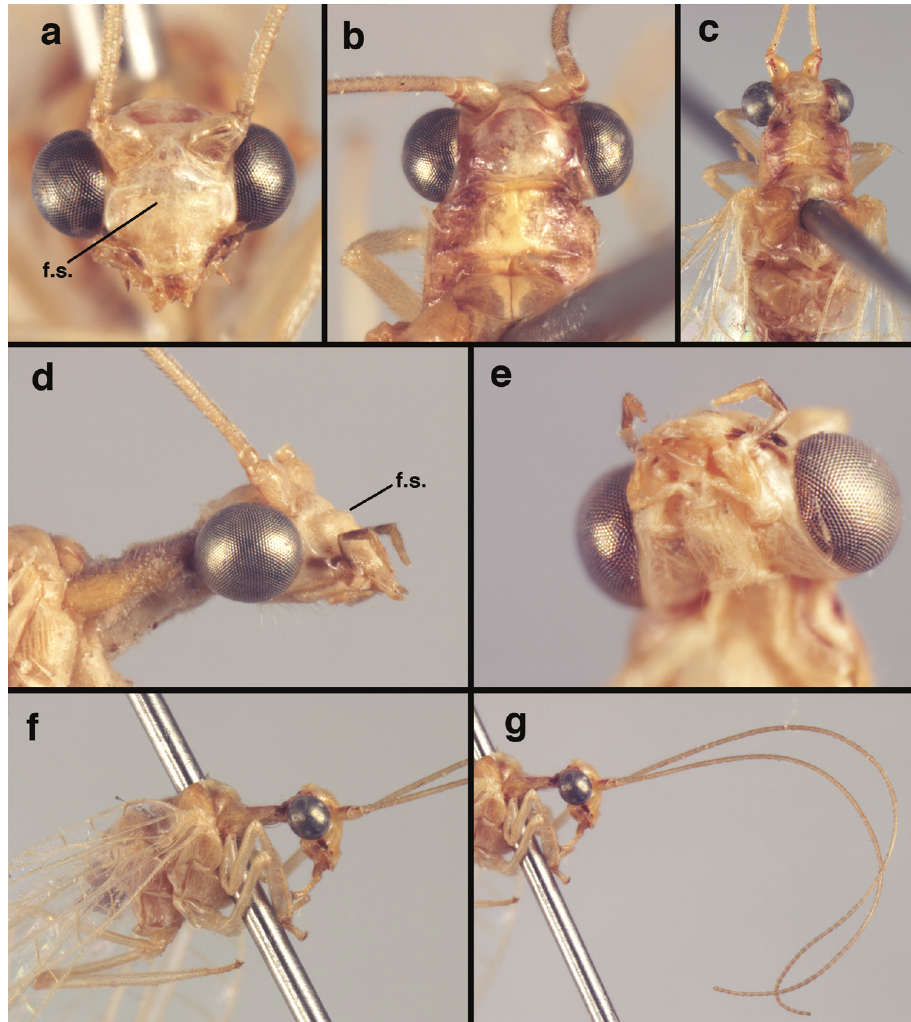
Figure 21. Ungla curimaguensis Sosa: External features, ( a ) head, frontal ( b ) head, prothorax, dorsal ( c ) head, thorax, dorsal ( d ) head, prothorax, lateral ( e ) head, ventral ( f ) head, thorax, lateral ( g ) head, antenna, lateral. f.s. frontal swelling (all: Venezuela, Aragua, Rancho Grande; a, b, d, e male, USNM c, f, g female, USNM).